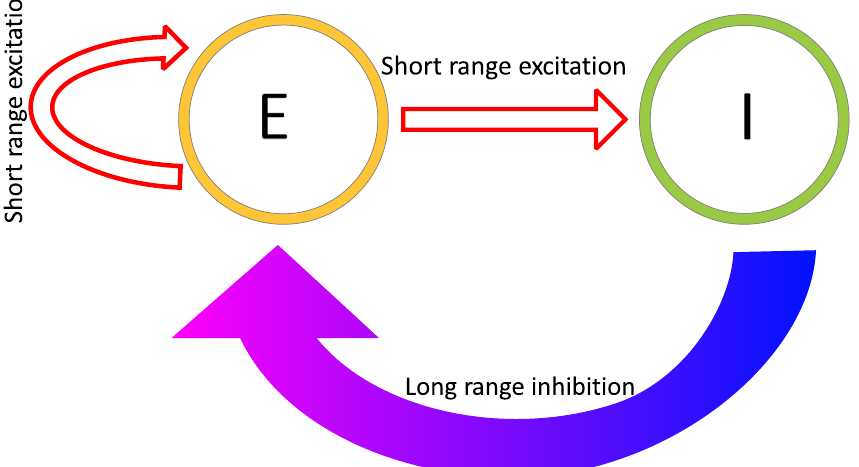
Figure 6. Figure on Activator (E) and Inhibitor (I) reagent levels. The activator E can increase levels of both itself and the inhibitor I, over the short range. The inhibitor reduces the levels of the activator over the long